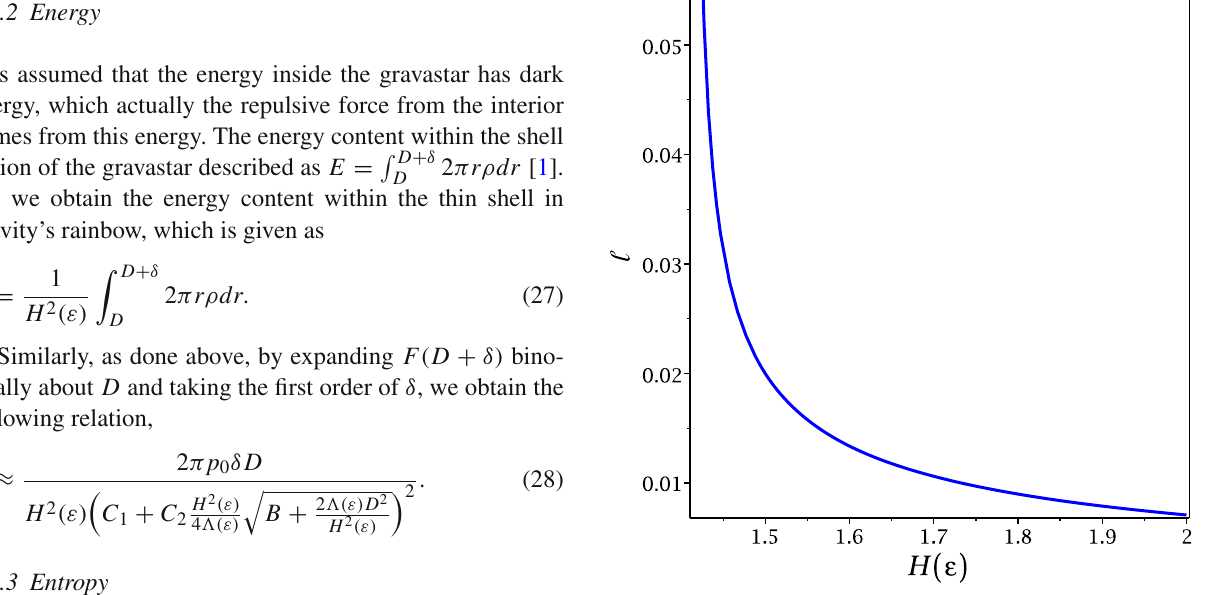
Fig. 1 The proper length ( l ) vs the rainbow function ( H (ε) ). We have